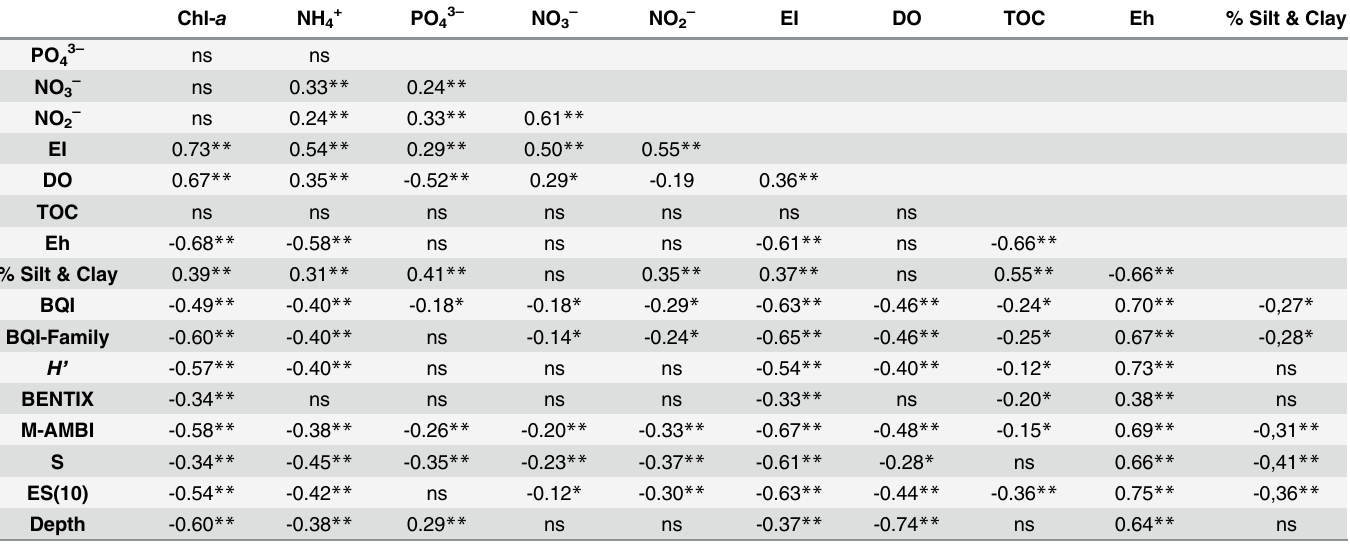
Table 5. Spearman rank correlation between biological and geochemical variables and/or indices. Chl- a , chlorophyll a ; EI, Eutrophic Index; DO, dis- solved oxygen; TOC, total organic carbon; Eh, redox potential; S, number of species; ES(10), expected number of species for 10 individuals; BQI, Benthic Quality Index; BQI-Family, Benthic Quality Index – Family; H ’ , Shannon Diversity Index; BENTIX, Benthic Index; M-AMBI, Multivariate AZTI Marine Biotic